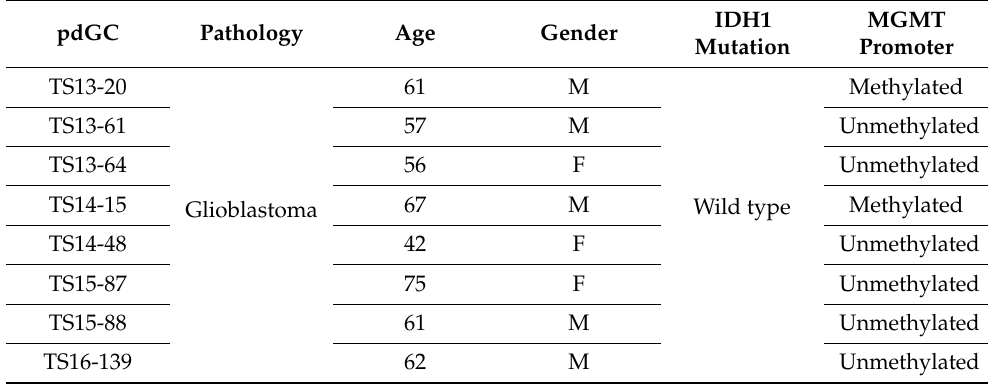
Table 1. List of patient-derived glioblastoma cells (pdGCs) used in this study. IDH1 MGMT pdGC Pathology Age Gender Mutation Promoter TS13-20 61 M Methylated TS13-61 57 M Unmethylated TS13-64 56 F Unmethylated TS14-15 67 M Methylated Wild type Glioblastoma TS14-48 42 F Unmethylated TS15-87 F Unmethylated TS15-88 61 M Unmethylated TS16-139 62 M